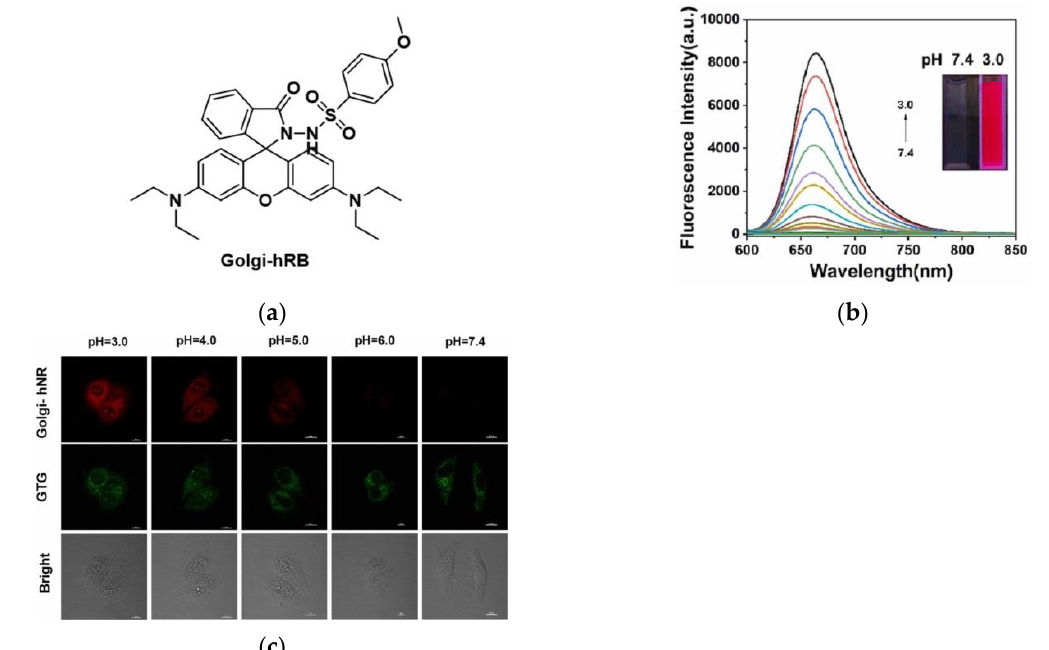
Figure 17. ( a ) Structure of Golgi-hNR; ( b ) Fluorescence spectra of Golgi-hNR; (c ) Imaging of HepG-2 cells in different acidic environments. Reproduced with permission from [78]. Copyright 2022 Elsevier B.V.